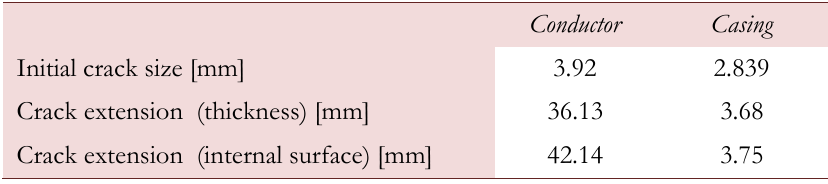
Table 8: Characteristic crack dimensions at Stage